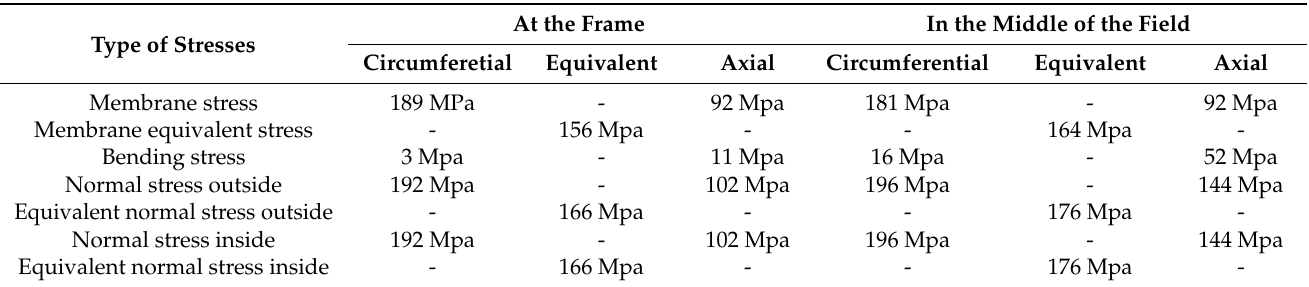
Table A2. Stresses at the nominal diving depth for the SFG baseline design in the free flooding compartment.